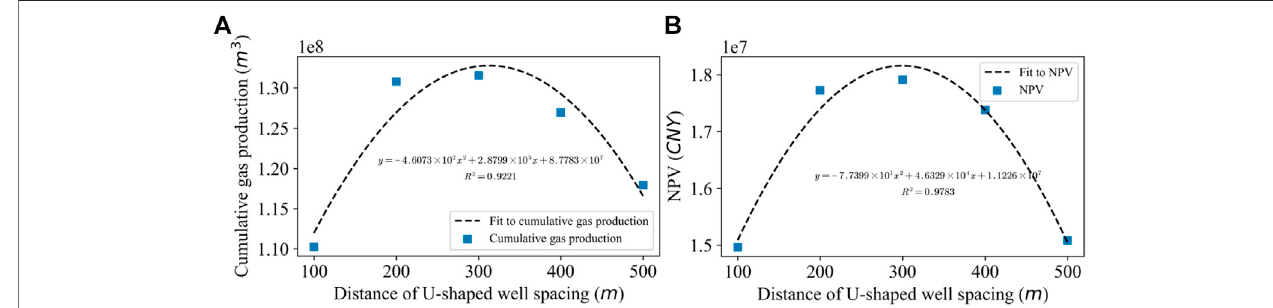
FIGURE 11 | Schematic diagram of numerical simulation of the fl oor fracturing horizontal well and coal pillar connection among a pilot test well group: U1-3 is the U-shaped along-dip horizontal well group; H1 is the horizontal well drilled in the fl oor; and FS1-5 is the pilot test well group.